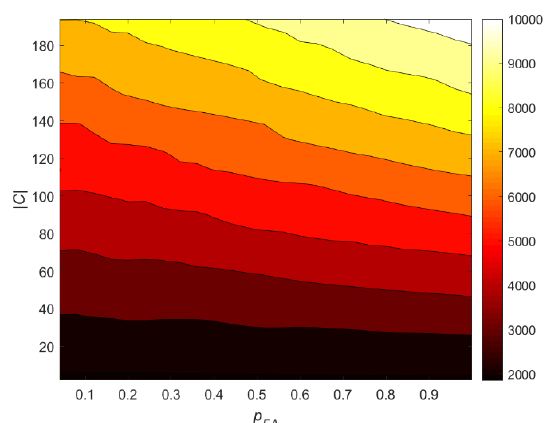
Figure 16. The total network power consumption vs. the total number of available channels in each macrocell (i.e., |Ϲ| ) and the probability of false alarm 𝑝 𝐹𝐴 .